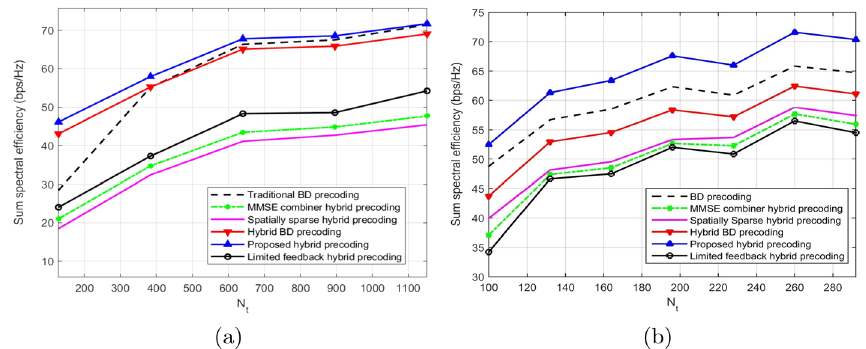
Fig. 3 Achievable spectral efficiency comparison against the number of BS antennas in ( a ) mmWave channel; ( b ) Rayleigh